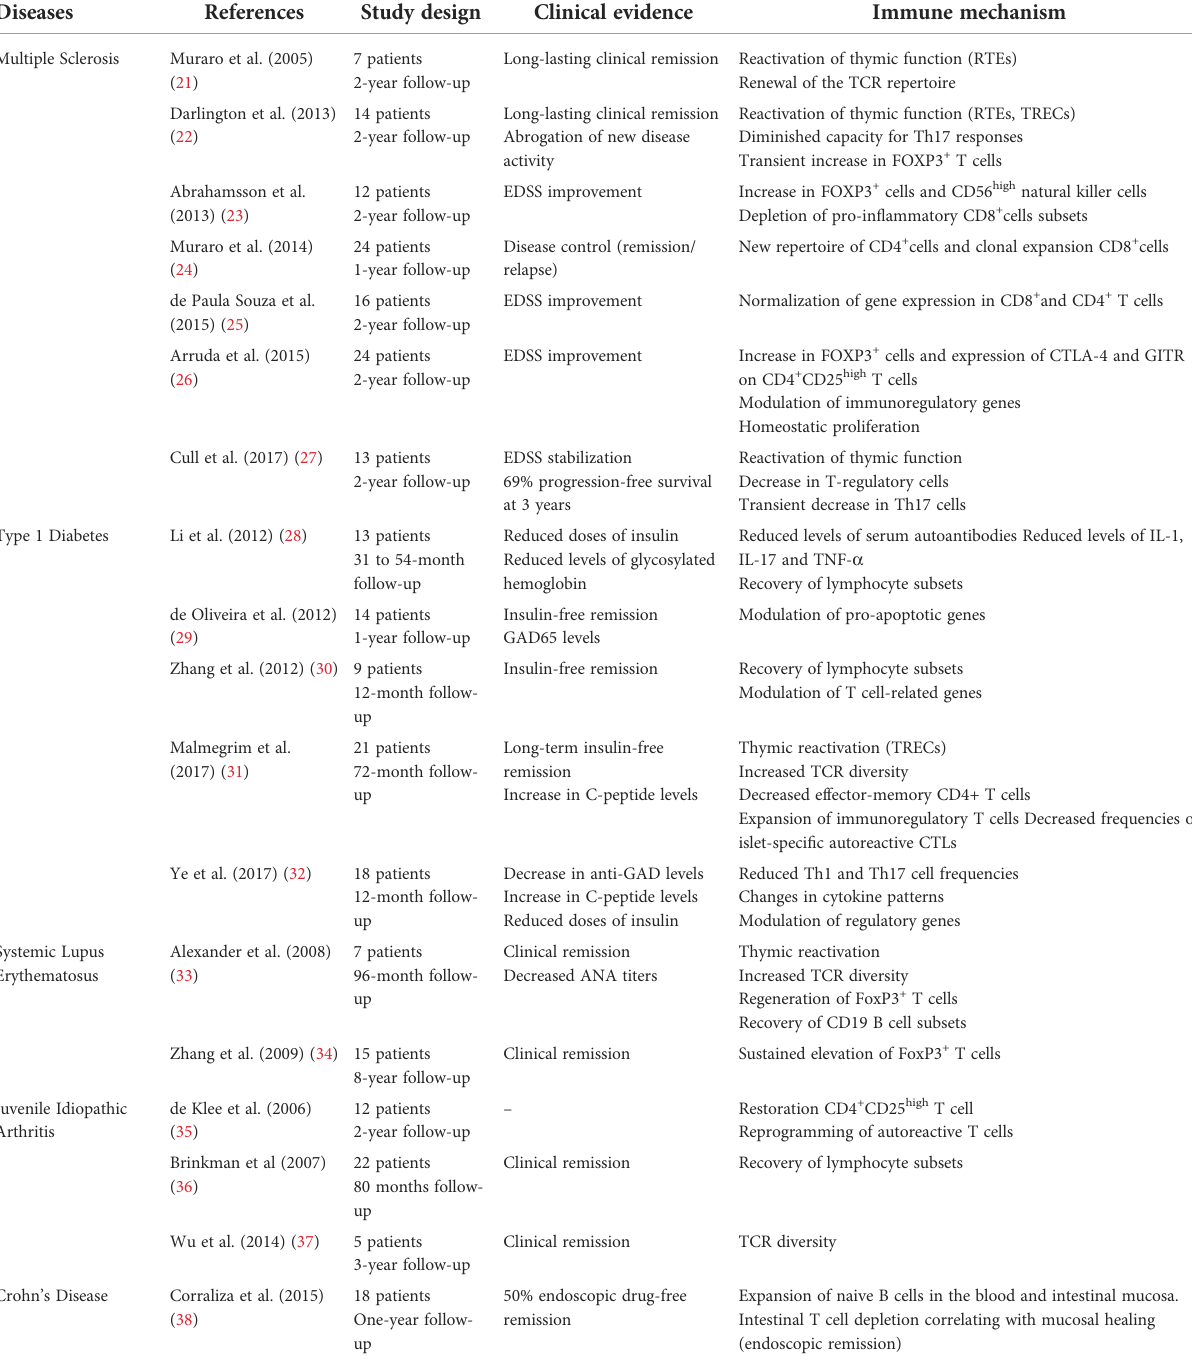
TABLE 1 Main clinical studies on autologous HSCT for autoimmune diseases (systemic sclerosis excluded) addressing mechanisms.